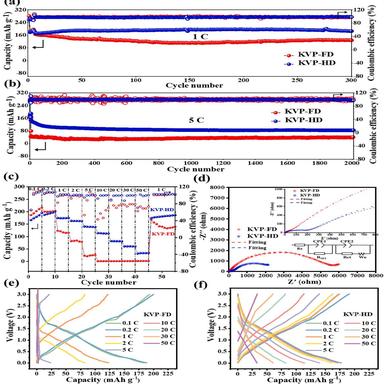
Cycle stability at (a) 1C and (b) 5C, (c) rate performance, (d) EIS curve, (e-f) voltage profiles of KVP-FD and KVP-HD electrodes at different C-rates.